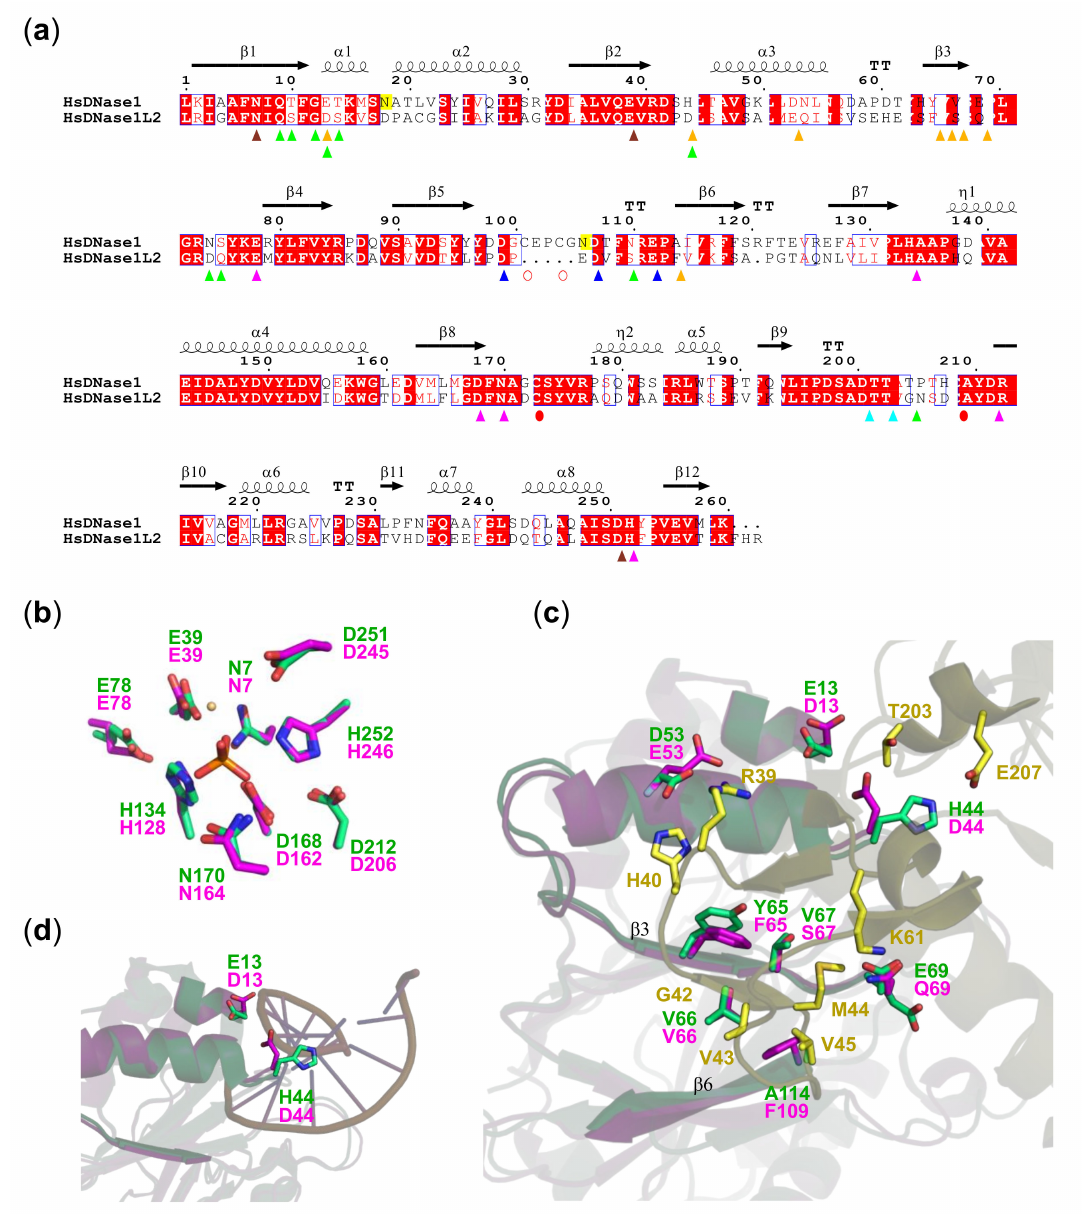
Figure 4. DNase1L2 exhibits conservation of DNase1 active site and diversity of the actin-binding region. ( a ) Aligned sequences of human DNase1 (HsDNase1) and DNase1L2 (HsDNase1L2). The residue numbering refers to the DNase1 sequence and is the same as in the structure in ( b – d ). The signal sequence that is cleaved prior to secretion in both DNases is not shown. Secondary structure elements inferred from 4AWN are shown above the alignment. Remarkable residues are indicated as follows: catalytic, pink triangles; Mg 2+ binding, brown triangles; Ca 2+ binding in site I, cyan triangles; Ca 2+ binding in site II, blue triangles; actin binding, orange triangles; DNA binding, green triangles; conserved cysteines, red circles; cysteines present only in DNase1, open red circles; and N-linked glycosylation sites are highlighted in yellow. ( b ) Superimposition of the active sites of DNase1L2 homology model (pink carbons) and human DNase1 structure (4AWN; green carbons). Bound Mg 2+ (light orange) and phosphate (orange) ions are shown. ( c ) Superimposition of the DNase1L2 homology model (pink carbons) with the human DNase1 structure (4AWN; green carbons) and the actin-bovine DNase1 complex (1ATN; yellow carbons), showing the actin-binding region. The key residues involved in interactions are shown in sticks with labels. β -strands of DNase1L2 and DNase1 interacting with actin are labeled. ( d ) Superimposition of the DNase1L2 homology model (pink carbons) with 4AWN (green carbons) and the d(GGTATACC)2-bovine DNase1 complex (1DNK; magenta carbons), showing the DNA-binding region. The key residues involved in interactions are shown in sticks with